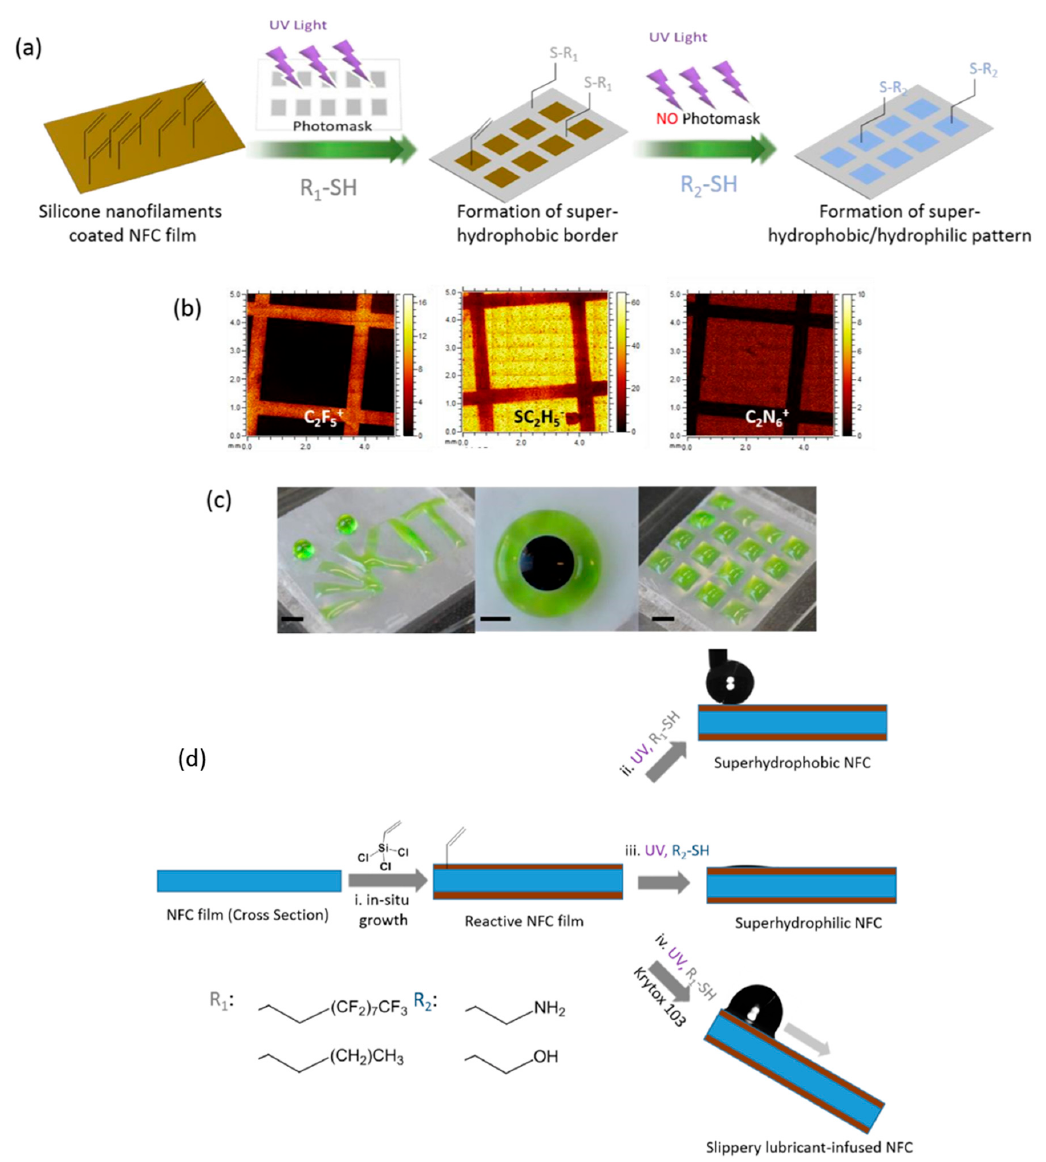
Figure 6. ( a ) modification of NFC films to produce superhydrophobic/superhydrophilic patterns. (R1 and R2–superhydrophobic and superhydrophilic moieties grafted on NFC film surfaces), ( b ) secondary ion mass spectroscopy with time of flight 2D mapping of superhydrophobic/superhydrophilic modified films with both positive (left and right) and negative (middle), ( c ) films designed with different patterns of superhydrophobic/superhydrophilic surfaces and highlighted with dyed water solutions. Reproduced with permission from Gou et al. [54]. ACS publications copyright © 2016 and ( d ) schematic of plausible chemical reactions to achieve superhydrophobic/superhydrophilic surfaces. Reproduced with permission from Fan et al. [55]. Elsevier copyright ©